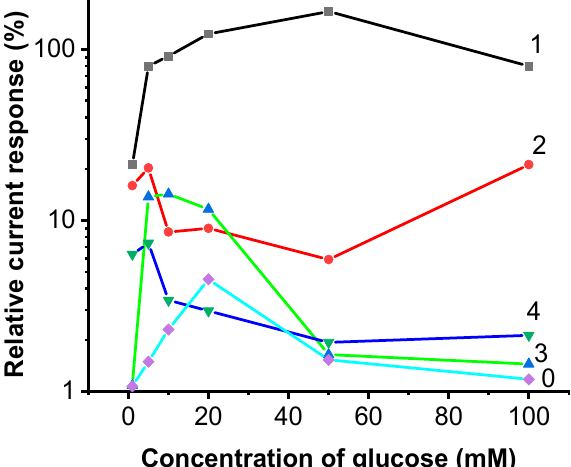
Figure 7. The dependence of relative change in current density from glucose concentration: 0—control; 1—EBFC CC —the system with Cytochrome c substrate; 2—EBFC CA —the system with Chlorophyll a substrate; 3—EBFC ChV —the system with the supernatant of ultrasonically disrupted Chlorella vulgaris cells substrate; 4—EBFC Hep —the system with heparin .